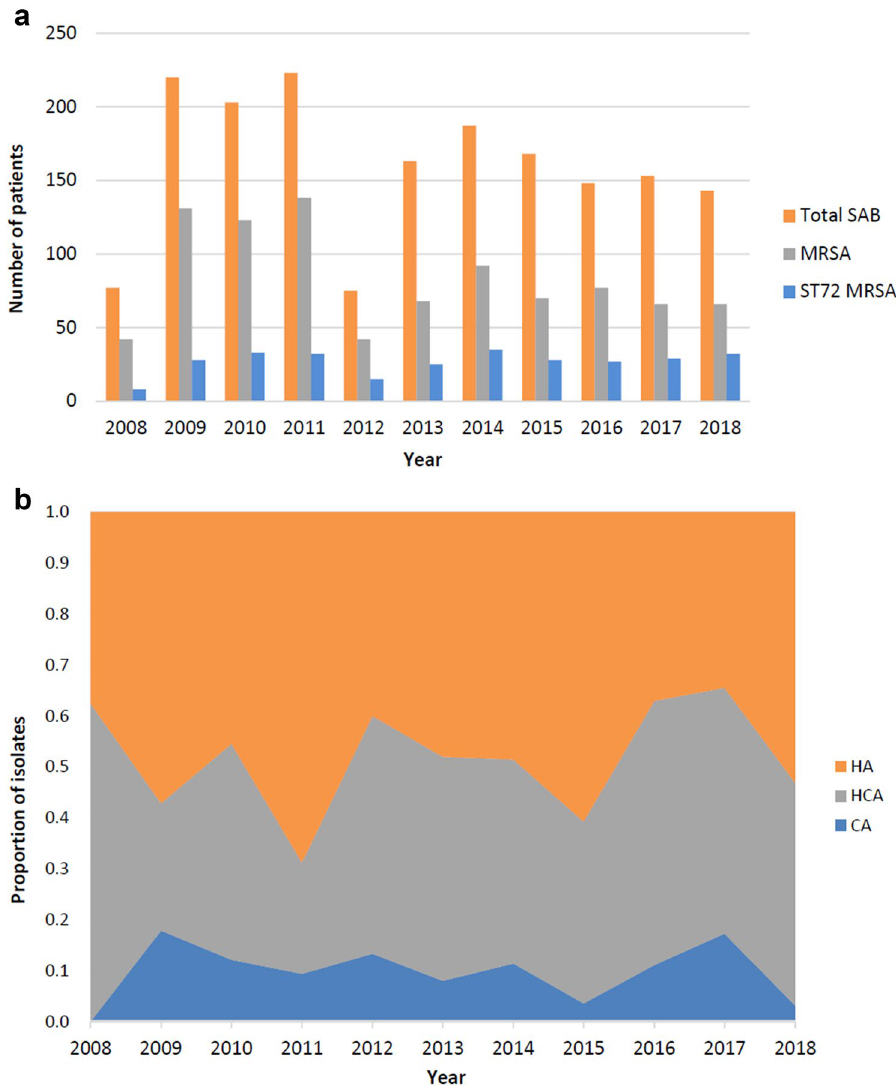
MRSA methicillin-resistant Staphylococcus aureus ; ST sequence type; HA Hospital-acquired; HCA healthcare- associated; CA